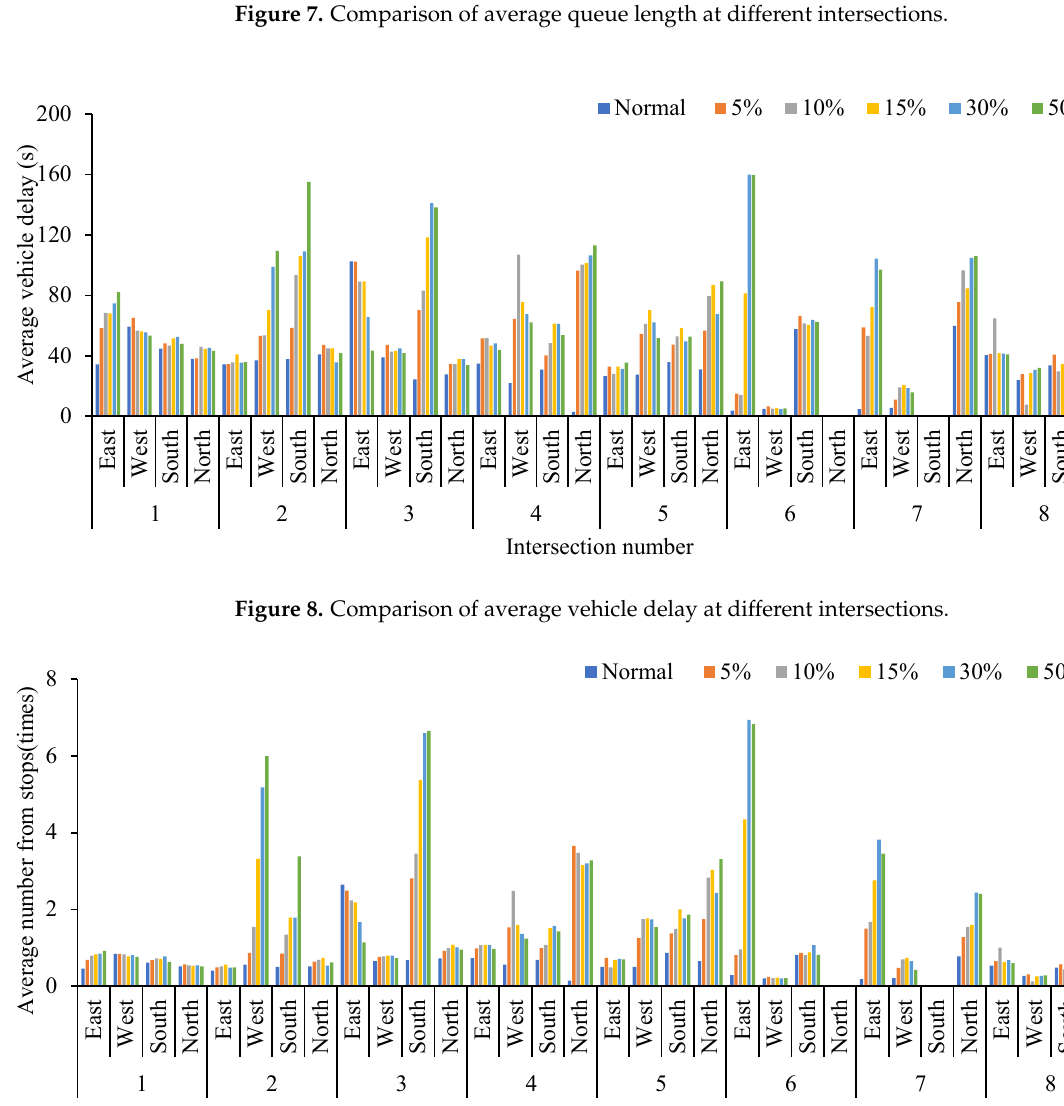
Figure 7. Comparison of average queue length at different intersections. Int. J. Environ. Res. Public Health 2022 , 19 , x FOR PEER REVIEW